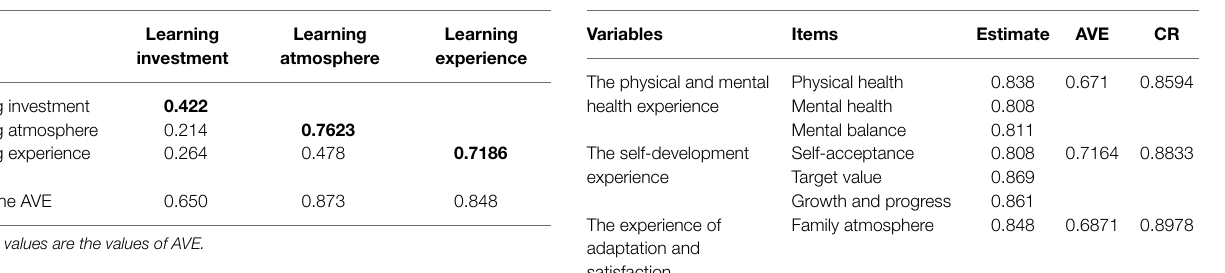
TABLE 3 | Correlation between older adult learning subscales. TABLE 4 | Results of CFA for